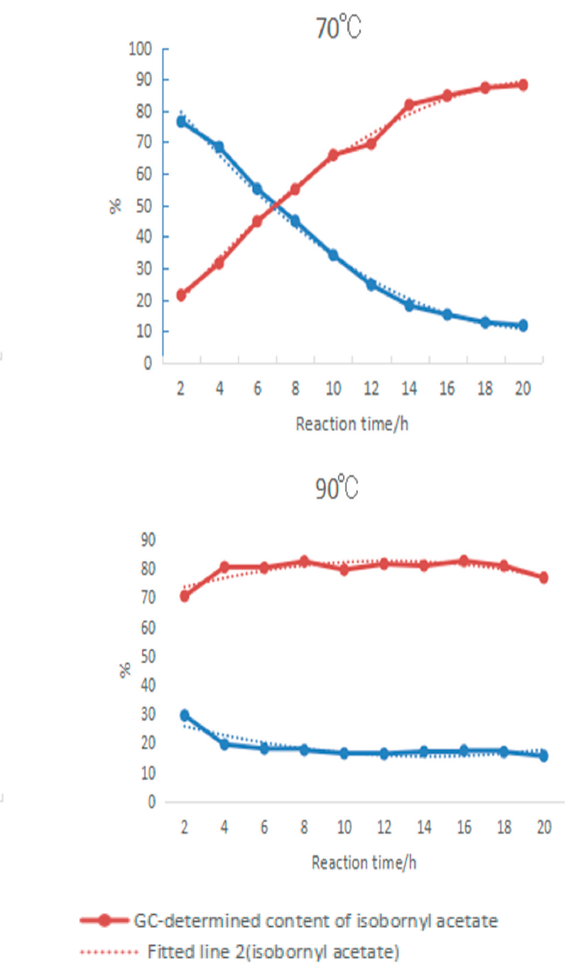
Figure 5. Variations in GC contents of camphene and isobornyl acetate in the product with increasing reaction time. The mass ratio between camphene, acetic acid, tartaric acid, and boric acid was 10:25:0.5:0.4.